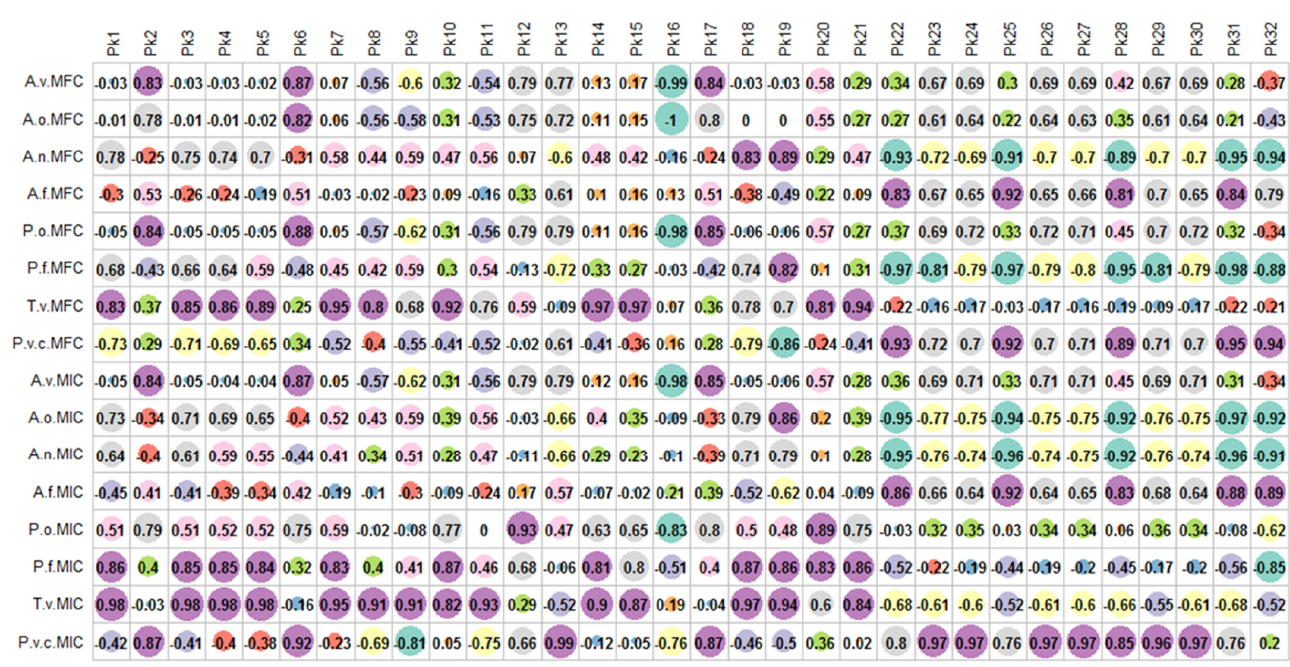
T. viride , the MIC of P. funiculosum and P. verrucosum var. cyclopium had significant positive correlation with a largest number of compounds. Contrary to anti-fungal activity, vary few significant positive correlation was found between anti-bacterial activities and chemical compounds. However, the bacteriostatic and bactericidal activities of S. typhimurium, as well as the bacteriostatic activity of E. coli seemed result from the action of a large number of chemical compounds.